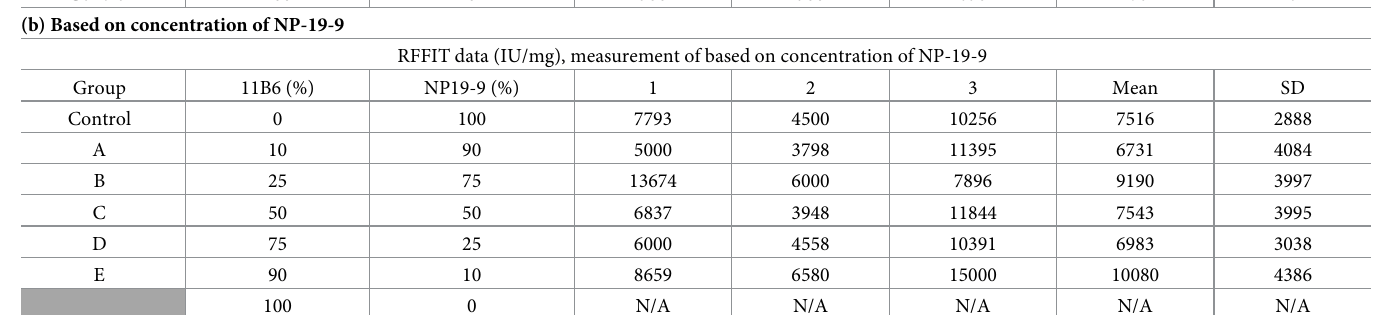
(b) Based on concentration of